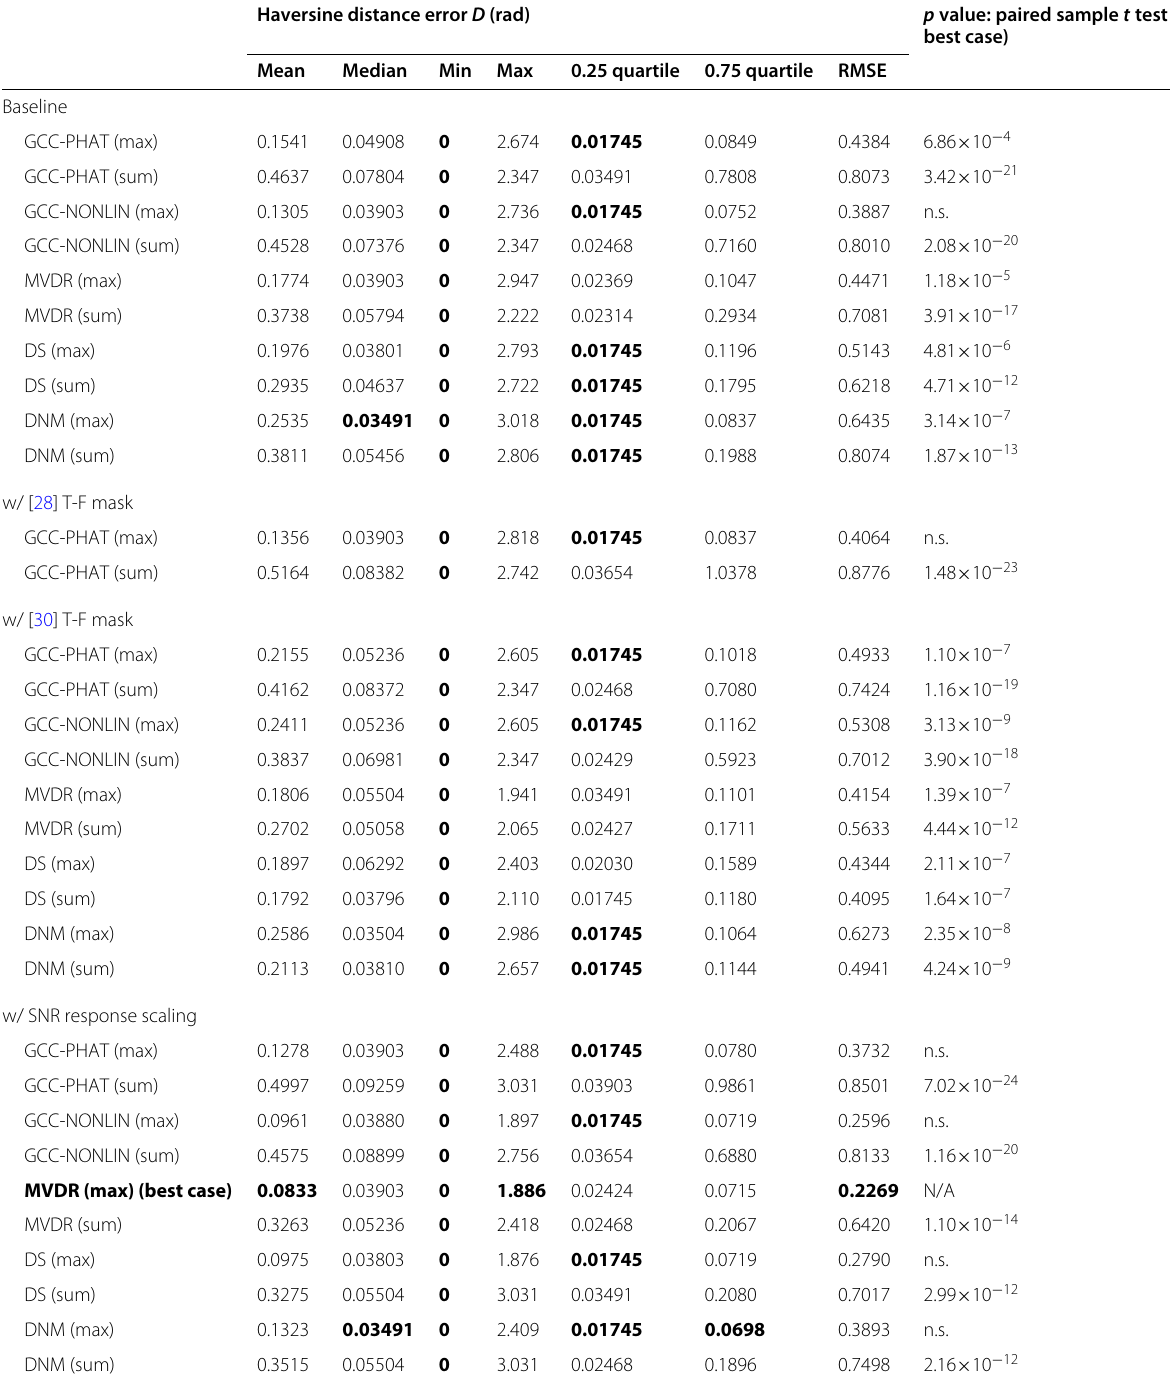
Table 3 Haversine distance error performance comparison (task 1—hovering UAV) Haversine distance error D (rad) p value: paired sample t test (ref.